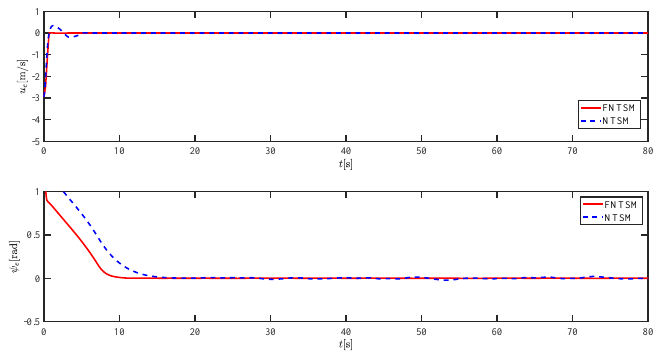
Figure 18. Sideslip angle estimations at moderate speed.